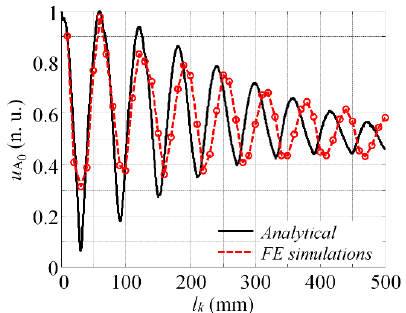
Figure 9. Magnitude variation of A 0 mode due to the size of the defect at a fixed depth: comparison between analytical calculations and finite element modeling.